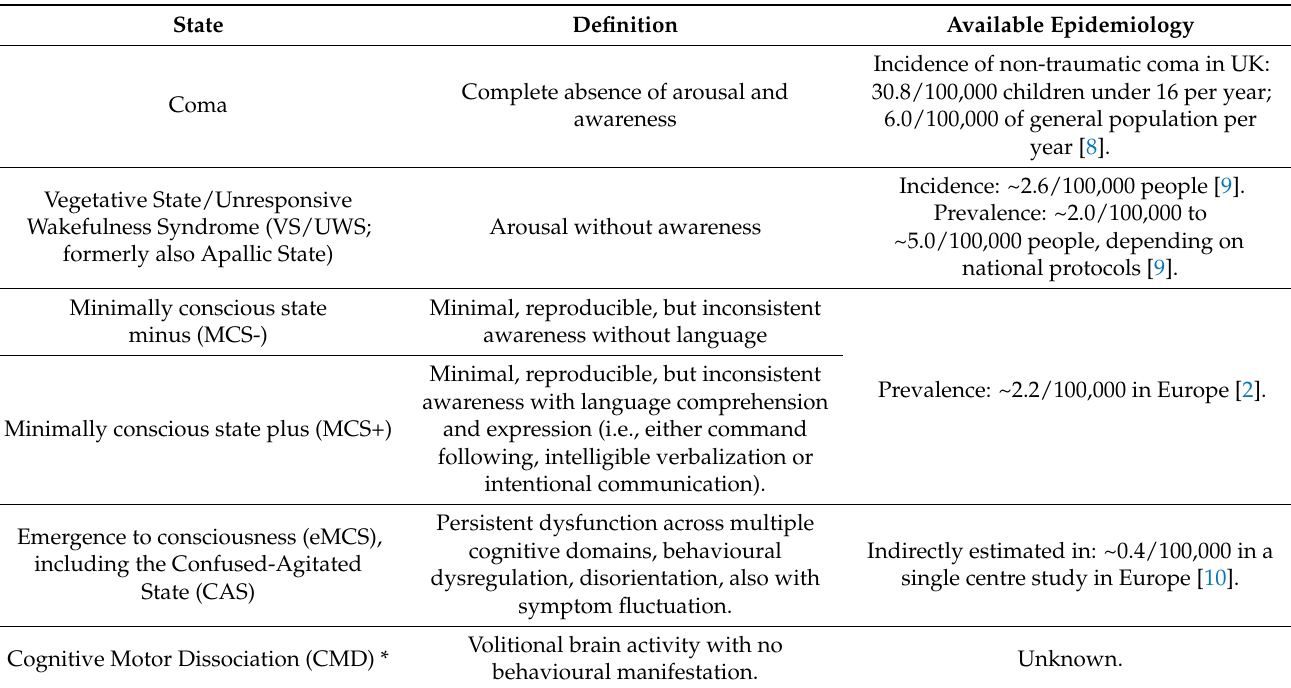
Definition Available